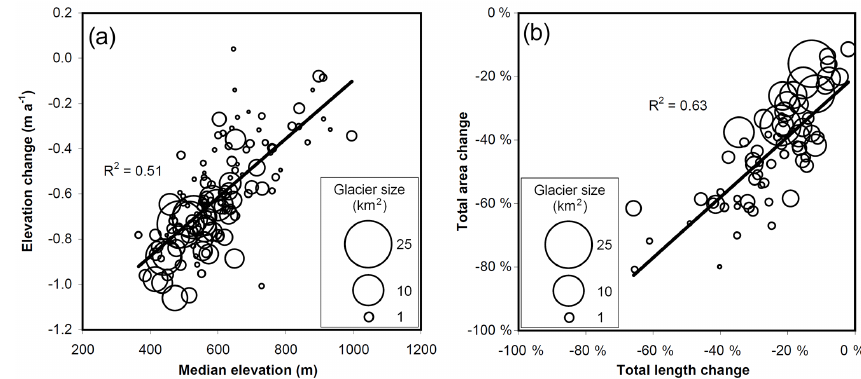
Figure 7. Scatter plots showing the relationship between mean 1990–2009/2011 glacier elevation change and median elevation of glaciers (a) and total area change and total length change of glaciers (b)